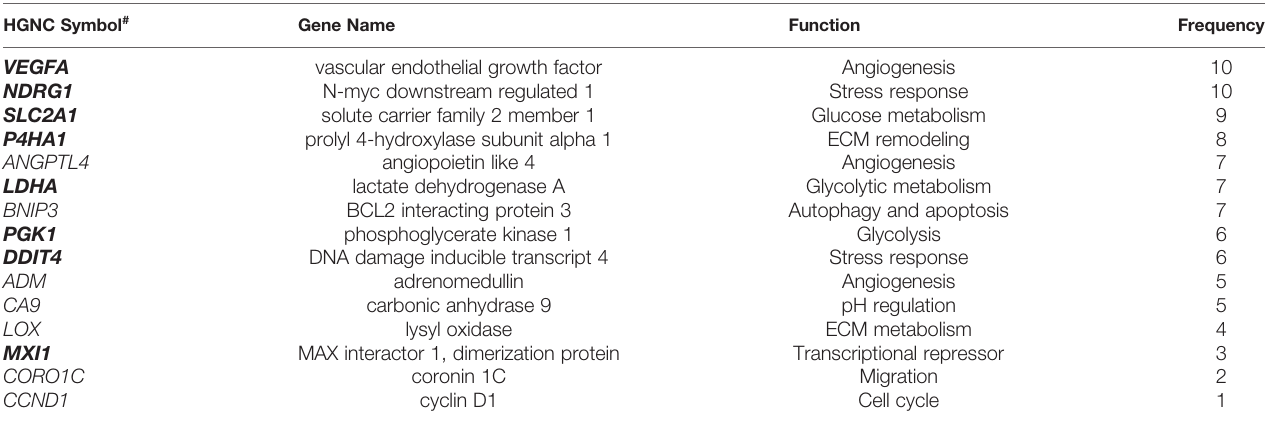
TABLE 2 | The 15 selected